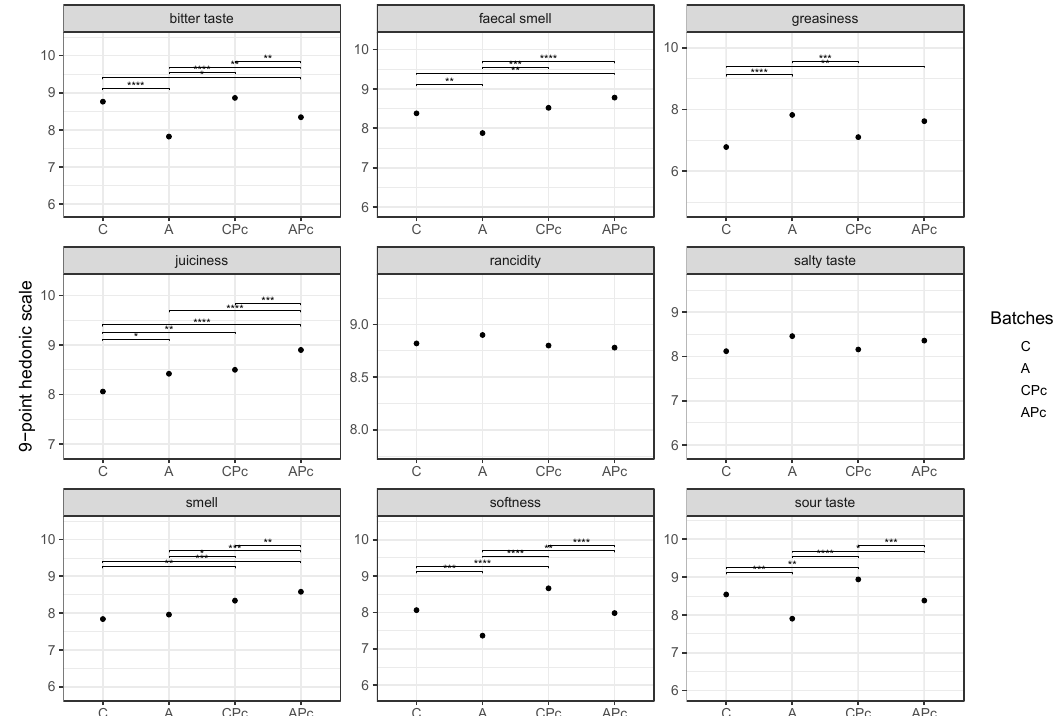
Figure 7. Jitter plot showing nine sensory attributes at the end of ripening time (42 days) in samples from batch C, conventional fermented sausage prepared with starter culture and 14% minced pork fat additions; batch A, prepared with 4% lemon albedo in total replacement of pork fat and starter culture addition; batch CPc, prepared with starter culture and 14% minced pork addition plus anti- Listeria Lactiplantibacillus plantarum Lpls100; batch APc, prepared with 4% lemon albedo in total replacement of pork fat and starter culture addition plus anti- Listeria Lactiplantibacillus plantarum Lpls100. Black dots represent the mean value of 50 records. Statistical significance: **** P < 0.0001; *** P < 0.001; ** P < 0.01; * P < 0.05.